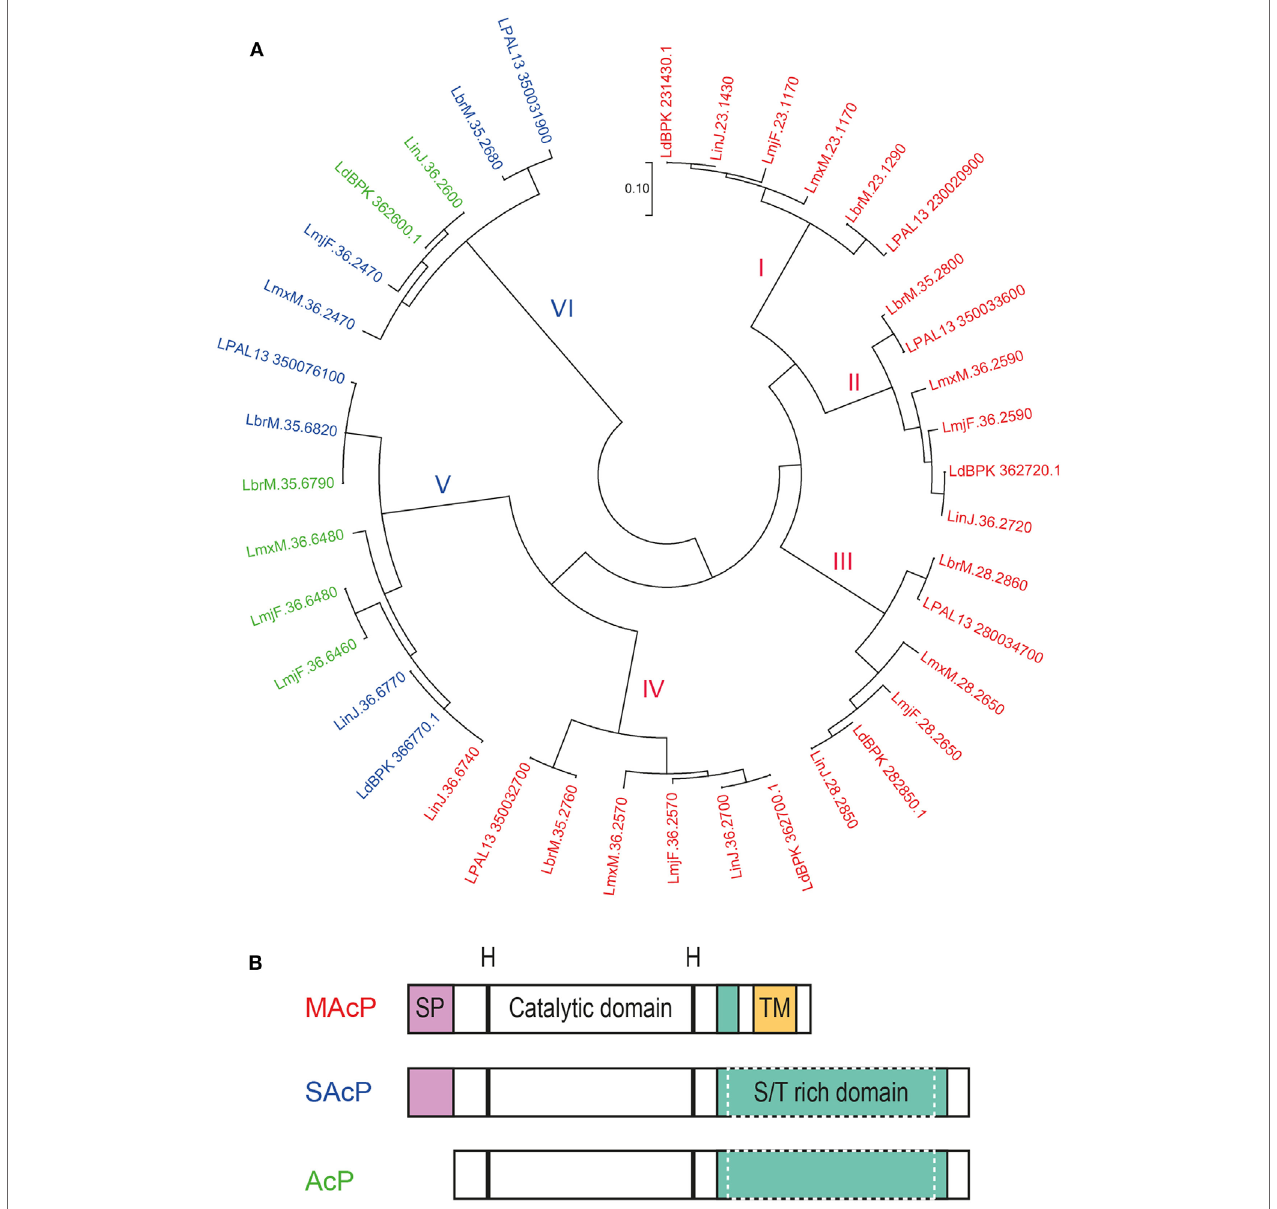
FigURe 4 | Acid phosphatases (AcPs) of Leishmania parasites. AcP, secreted by Leishmania parasites or expressed on their surface, belong to the family of histidine phosphatases. (A) Phylogenetic comparison between histidine phosphatases of L. major Friedlin, L. infantum JPCM5, L. donovani BPK282A1, L. mexicana MHOM/GT/2001/U1103, L. braziliensis MHOM/BR/75/M2904, L. panamensis MHOM/COL/81/L13. Available gene sequences were extracted from the TriTrypDB Kinetoplastid Genomics Resource database (IPR: 000560) and were used to construct a phylogenetic topology with the minimum evolution method. The evolutionary distance (scale) is measured in number of base substitutions per site. The evolutionary history was inferred using the Minimum Evolution method (142). The evolutionary distances were computed using the Maximum Composite Likelihood method (143) and are in the units of the number of base substitutions per site. The minimum evolution tree was searched using the Close-Neighbor-Interchange (CNI) algorithm (144) at a search level of 1. The Neighbor-Joining algorithm (145) was used to generate the initial tree. The analysis involved 39 nucleotide sequences. All positions containing gaps and missing data were eliminated. There was a total of 409 positions in the final data set. Evolutionary analyses were conducted in MEGA7.0.18 (146). Protein sequences of the respective genes were analyzed for the presence of a putative signal peptide (SP) and transmembrane domain (TM) with the Phobius software (147). Genes are labeled in red for the membrane AcP (MAcP) containing a signal peptide (SP) and transmembrane domain (TM), in blue for the secreted AcP (SAcP) containing only a SP and in green for the phosphatases lacking both domains. (B) Schematic organization of the protein domains of Leishmania AcP. Membrane and secreted AcP have a SP at their N-terminus followed by a catalytic domain based on histidine residues. Next, AcP harbor a serine/threonine(S/T)-rich domain that varies in length and can be significantly larger in SAcPs. Finally, MAcPs harbor a TM close to their C-terminus. Some AcPs (green in panel A) are devoid of SP and TM but can harbor long S/T-rich